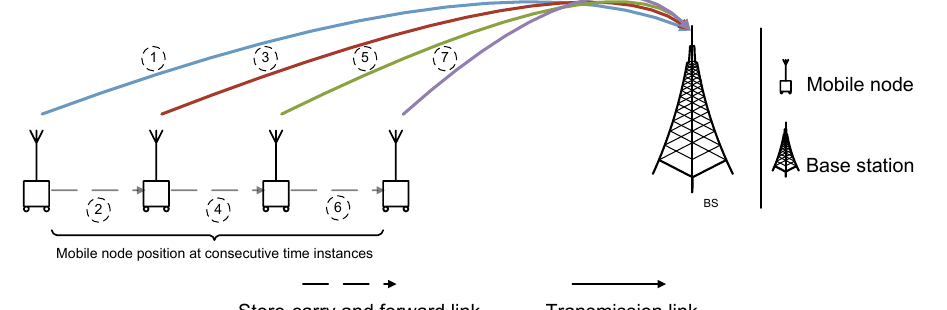
Figure 1. A single realization of the store-carry and forward paradigm employed by a mobile relay node within the